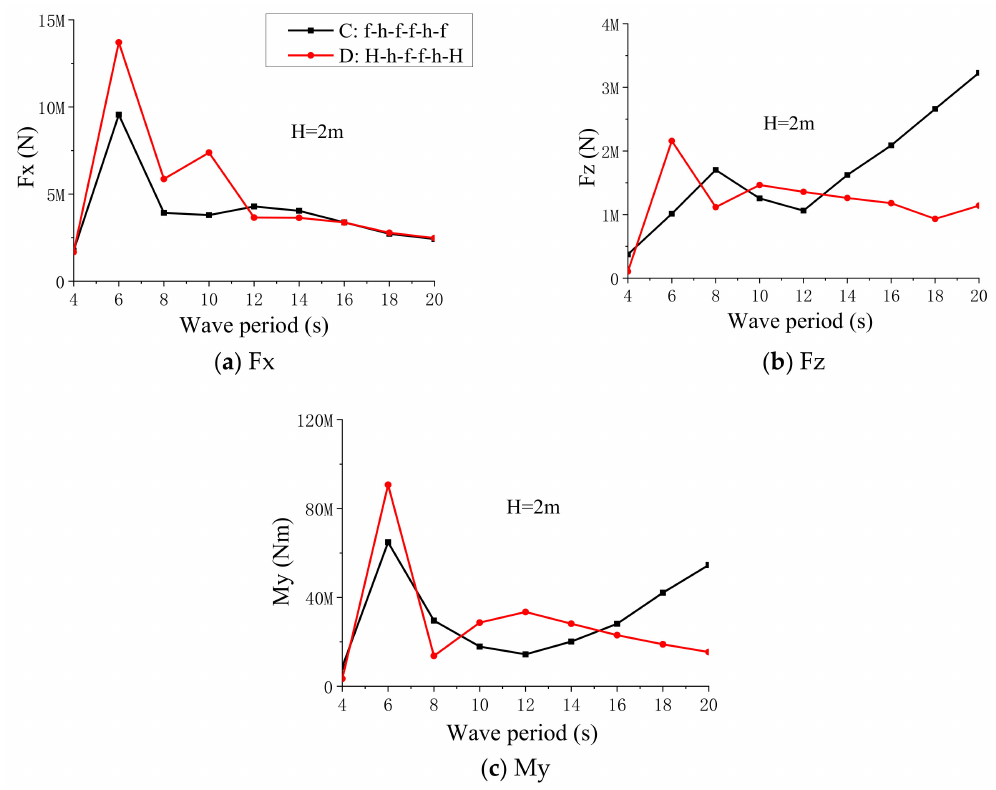
Figure 10. Maximum connector loads with two suggested connection modes under different wave periods: ( a ) Fx, ( b ) Fz, ( c )